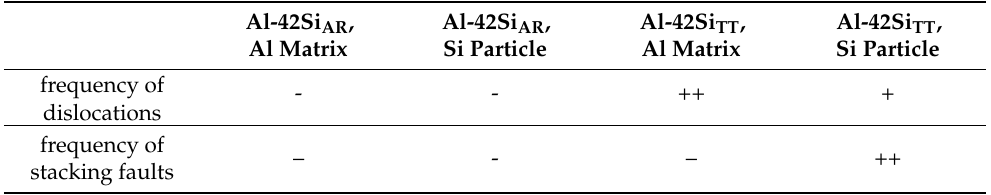
Table 2. Semi-quantitative classification of the defect density in each phase of the samples in the as-received and thermally treated conditions, respectively.